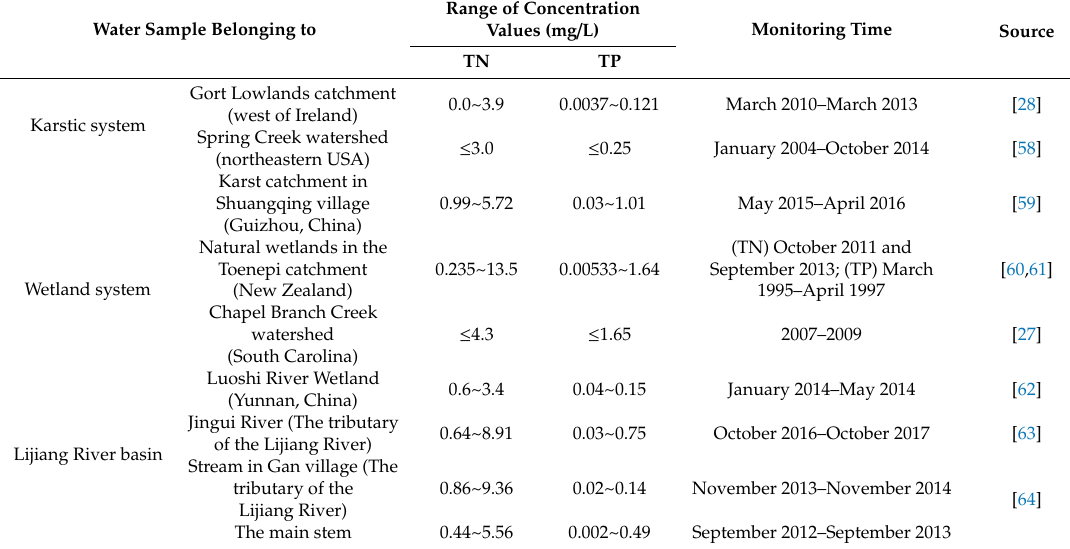
Table 8. Range of observed concentration of TN and TP in other karstic systems, wetland systems and rivers in Lijiang River